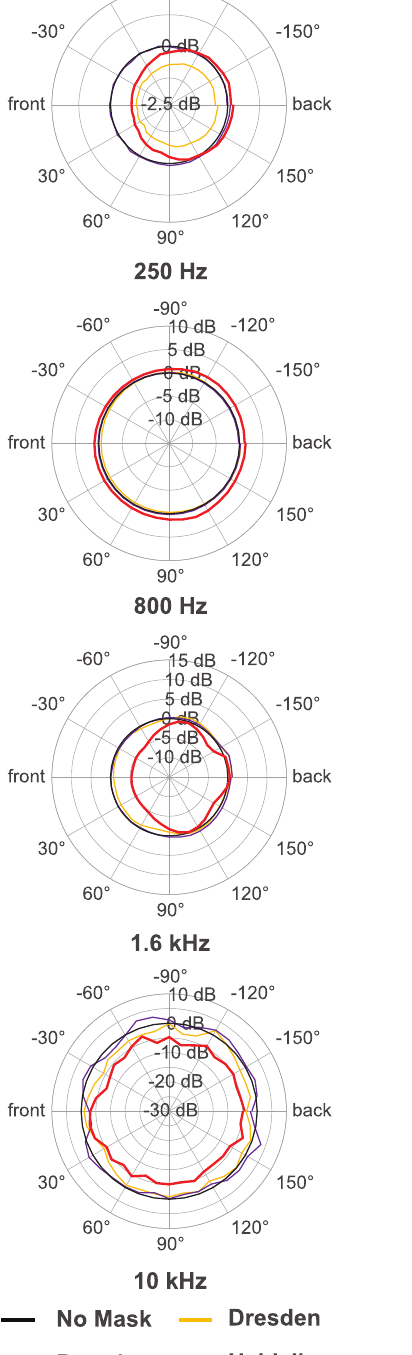
Figure 4. Polar plots of the sound radiation for the community masks Dresden, Broadway and Heidelberg normalized by the sound without (no) masks for speci fi c frequencies (250 Hz, 800 Hz, 1.6 kHz and 10 kHz). Front indicates the position of the KEMAR head with the mouth pointing at the microphone, back indicates the back of the head pointing towards the microphone.